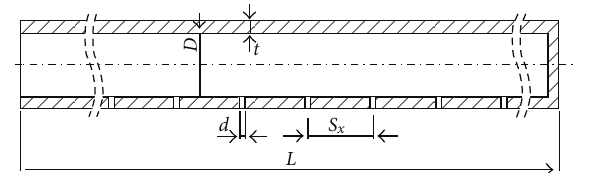
Figure 3: Multiple jet section geometry.